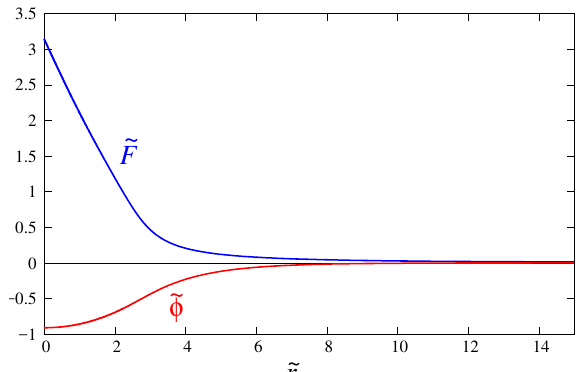
Figure 1 . ~ F (upper blue curve) and ~ (cid:30) (lower red curve) as functions of ~ r for the case of (cid:11) 4 = 0 : 1, (cid:11) 5 = (cid:0) 0 : 1. The kinetic part of the Lagrangian and the Higgs potential take the SM forms.